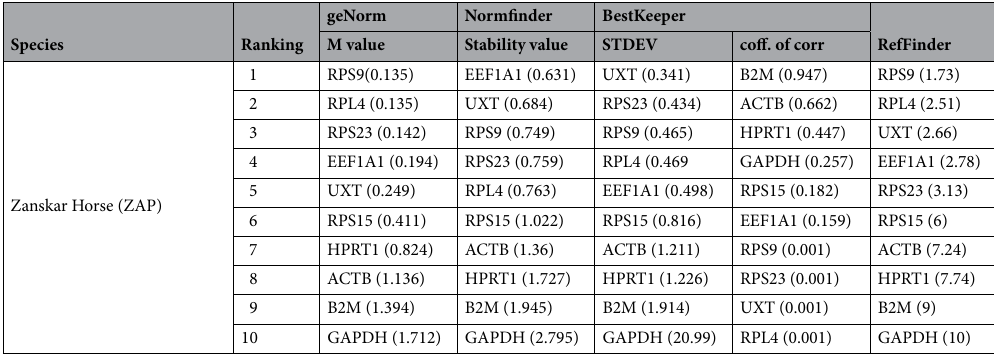
Table 3. Overall ranking of best suitable RGs across different species.